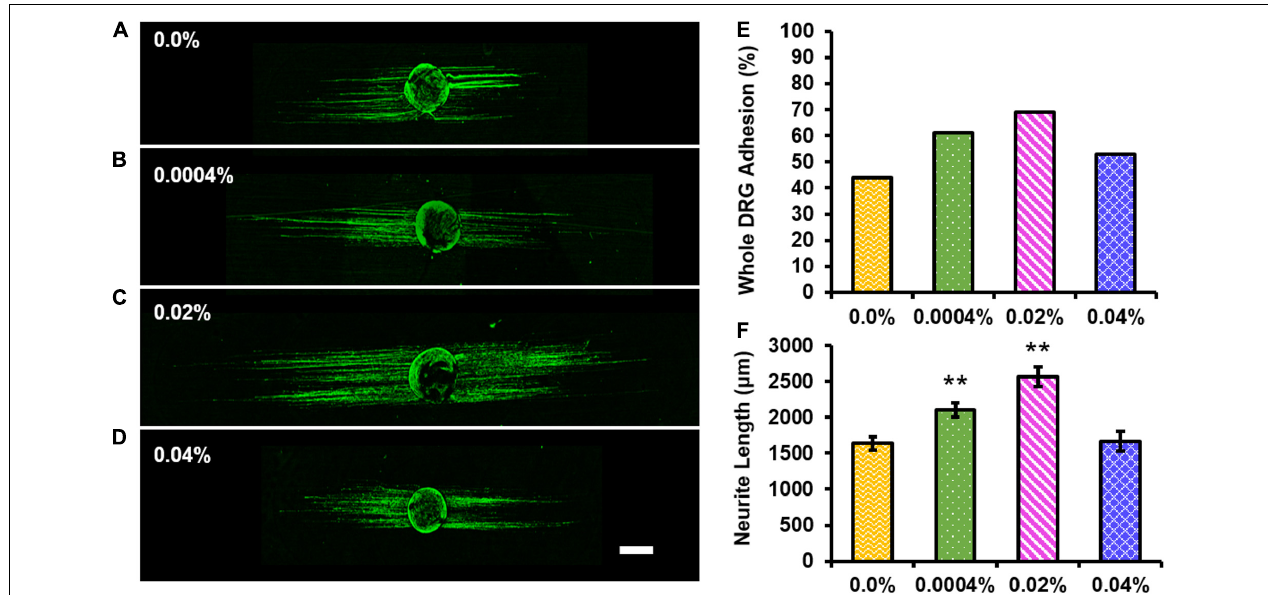
FIGURE 5 | The 0.0004 and 0.02% fingolimod-loaded electrospun fiber groups significantly increased neurite extension from whole dorsal root ganglia (DRG) explants. Confocal images of whole DRG stained against neurofilament (green) and cultured for 4 days on (A) 0.0%, (B) 0.0004%, (C) 0.02%, or (D) 0.04% fingolimod-loaded poly(lactic-co-glycolic acid) electrospun fibers (scale bar = 500 µ m). (E) Whole DRG total percent adhesion data show the percentage of the total number of whole DRG that remained adhered to each fiber type after 4 days in culture. (F) Neurite length data are represented by the mean length (in µ m) ± standard error of the mean. Statistical significance compared with the 0.0% control fibers was assessed using one-way ANOVA and post hoc Dunnett’s test (** p <